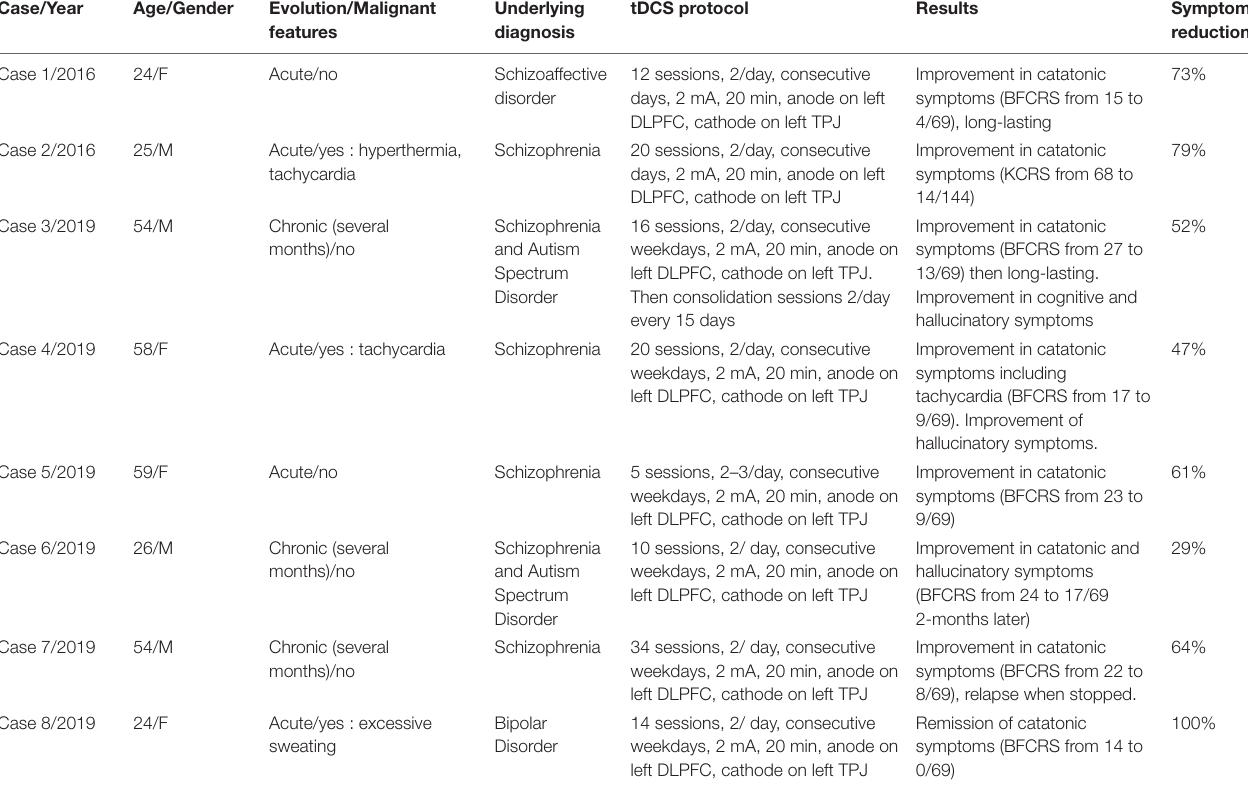
TABLE 2 | Case series of catatonia treated with transcranial direct